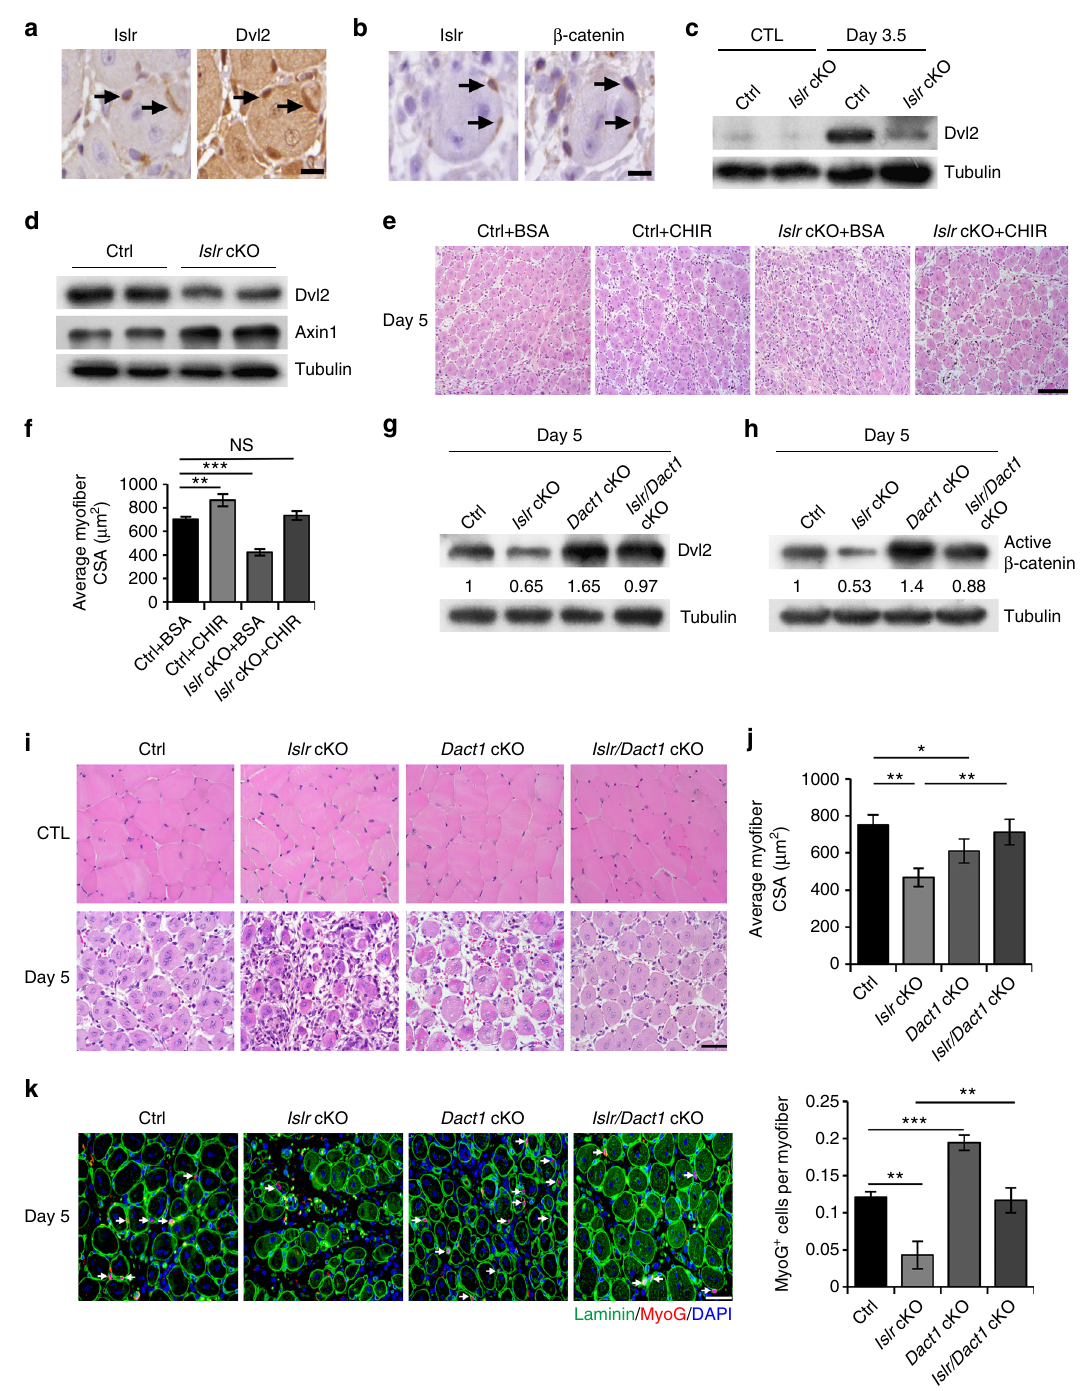
Fig. 8 The ablation of Dact1 rescues the impaired skeletal muscle regeneration of Islr cKO mice by upregulating Dvl2. a Immunohistochemistry analysis of Islr and Dvl2 in injured TA muscles of WT mice at 5 d postinjury using serial sections. Scale bar = 10 μ m. b Immunohistochemistry analysis of Islr and β - catenin in injured TA muscles of WT mice at 5 d postinjury using serial sections. Scale bar = 10 μ m. c Western blot analysis of Dvl2 protein levels in injured and CTL of control and Islr cKO mice at 3.5 d post injury. d Western blot analysis of Dvl2 and Axin1 protein levels in isolated satellite cells of control and Islr cKO mice cultured for 2 d in differentiation medium. e Intramuscular injection of CHIR or BSA at 2.5 d postinjury and H&E staining of injured TA muscles of control and Islr cKO mice at 5 d postinjury. N = 3 in each group. Scale bar = 100 μ m . f CSA of myo fi bers in ( e ). g Western blot analysis of Dvl2 protein levels in injured TA muscles of control, Islr cKO, Dact1 cKO, and Islr / Dact1 cKO mice at 5 d postinjury. h Western blot analysis of active β -catenin protein levels in injured TA muscles of control, Islr cKO, Dact1 cKO, and Islr / Dact1 cKO mice at 5 d postinjury. i H&E staining of injured and contralateral TA muscles in control, Islr cKO, Dact1 cKO, and Islr / Dact1 cKO mice at 5 d postinjury. Control (Ctrl): N = 5; Islr cKO: N = 3; Dact1 cKO: N = 3; Islr / Dact1 cKO: N = 3. Scale bar = 50 μ m. j CSA of myo fi bers in ( i ). k Immuno fl uorescence analysis of MyoG + cells in TA muscles of control, Islr cKO, Dact1 cKO, and Islr / Dact1 cKO mice at 5 d postinjury. N = 3 in each group. Scale bar = 50 μ m. The numbers of MyoG + cells per myo fi ber are shown on the right. Error bars represent the means ± s.d. * P < 0.05, ** P < 0.01, *** P < 0.001; Student ’ s t